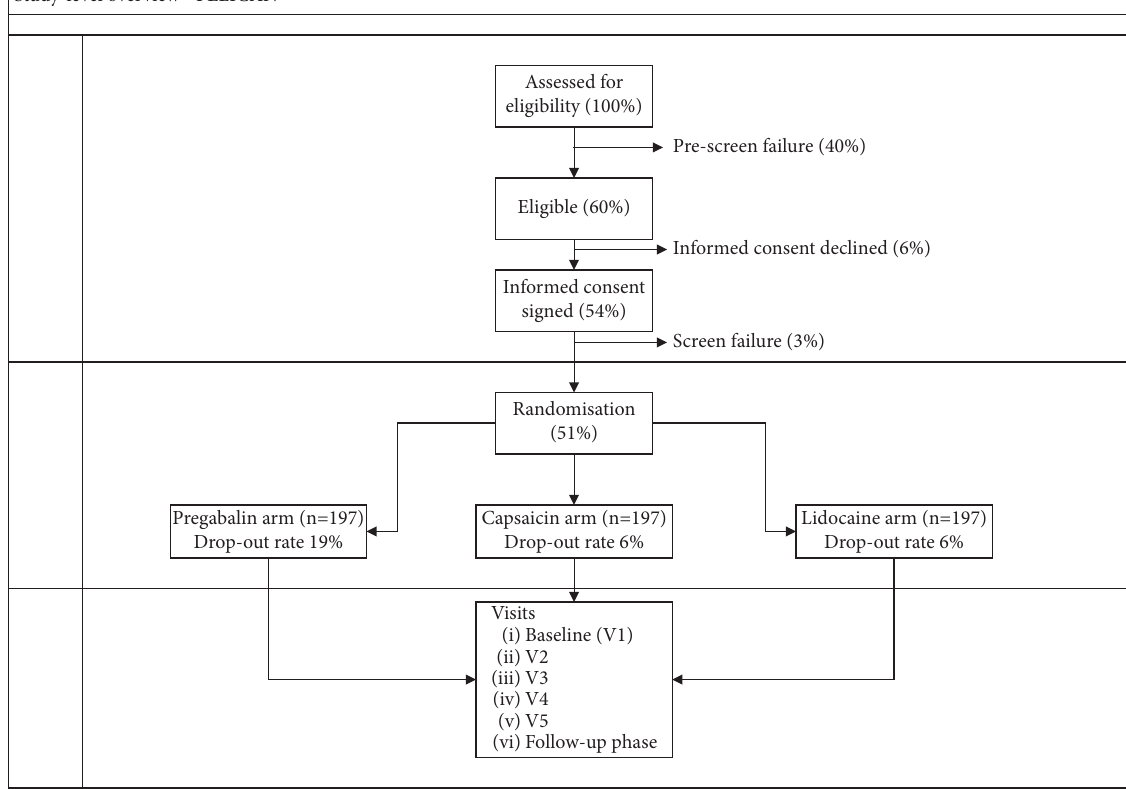
Figure 1: Overview of the study design of the PELICAN pragmatic trial as originally